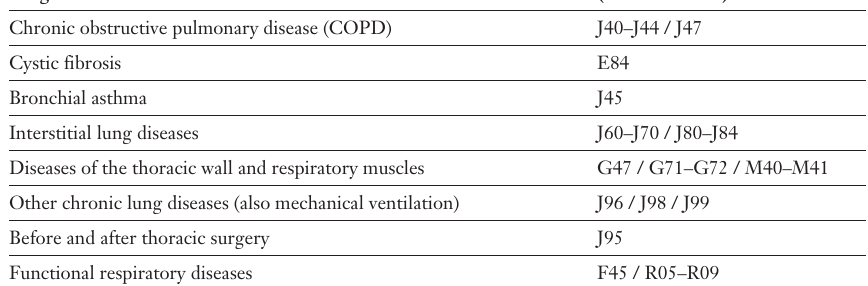
Indications for pul- monary rehabilitation